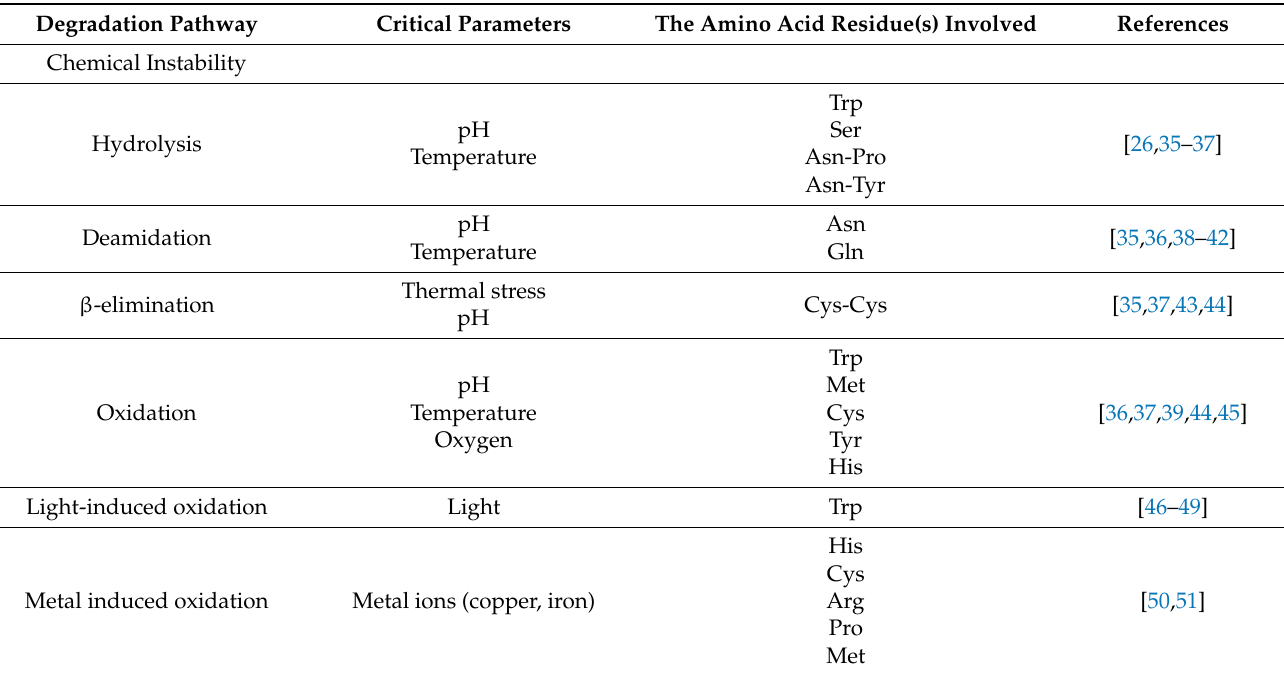
Table 3. Degradation pathways of peptide in aqueous solution, critical parameters, and amino acid residue(s)